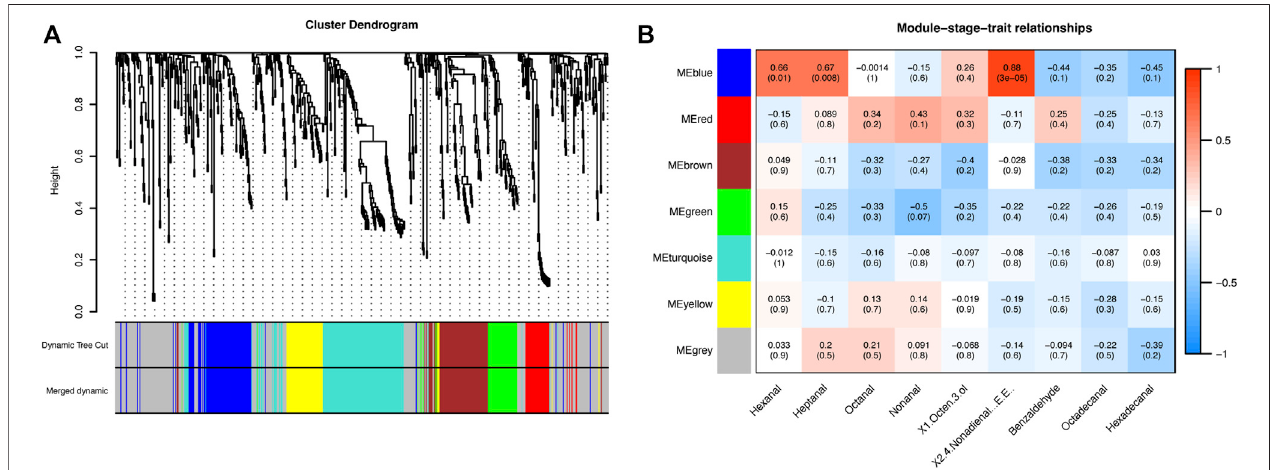
FIGURE 4 | (A) Hierarchical clustering presenting seven modules with co-expressed metabolites in BM tissue. Each lea fl et in the tree corresponds to individual metabolicpathways. (B) Module-stage-tissuerelationshipsbetweenmetabolitemodulesandmajorvolatilecompoundsinBMtissue.Theuppernumberinthemoduleis the correlation coef fi cient between modules and bottom traits, and the lower number is the p -value of the correlation coef fi cient.